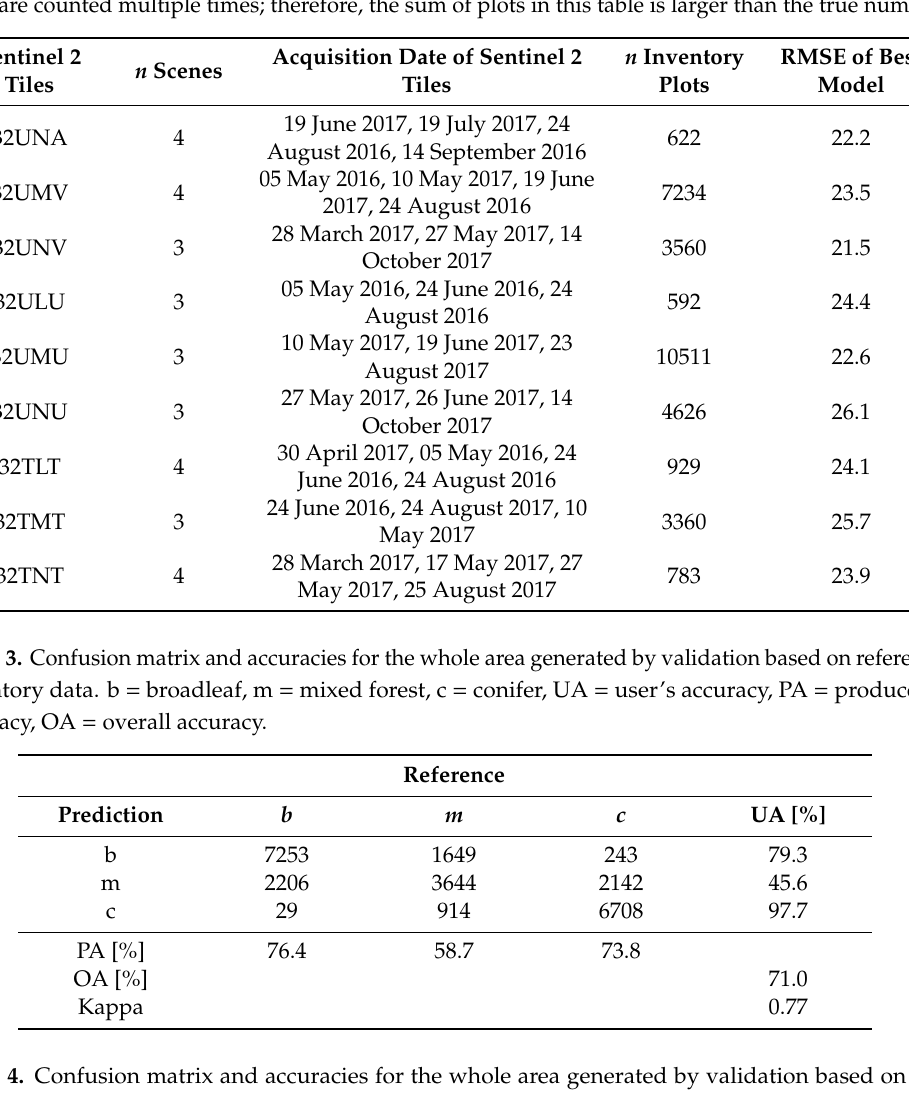
Table 2. Number and dates of multi-temporal Sentinel 2 tiles used in the final model, and number of forest inventory plots located in each tile. Note that in areas where S-2 tiles are overlapping inventory plots are counted multiple times; therefore, the sum of plots in this table is larger than the true number.